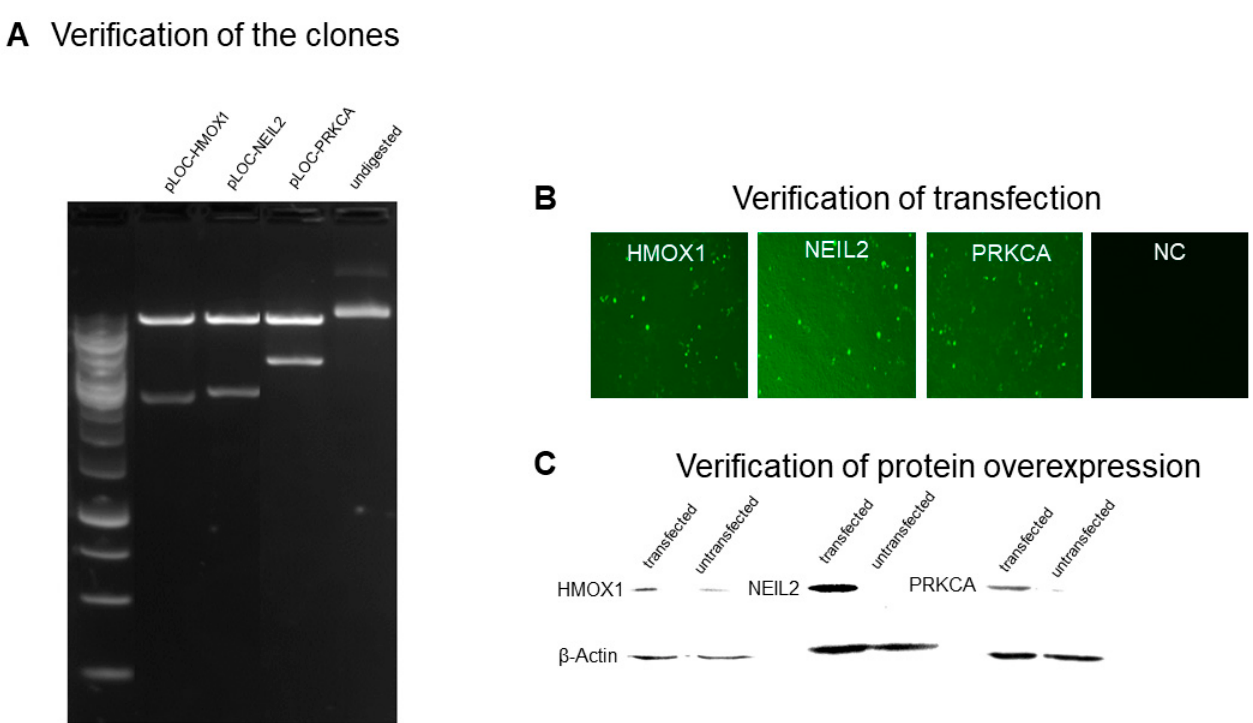
Figure 2. Transfection of HEK293 cells with HMOX1, NEIL2 , and PRKCA plasmid constructs. ( A ) Verification of the clones after EcoRI digestion. ( B ) Verification of transfection with GFP signal observation under a fluorescent microscope. ( C ) Verification of protein overexpression for HMOX1, NEIL2, and PRKCA. β -actin was used as a loading control. NC, non-transfected control.